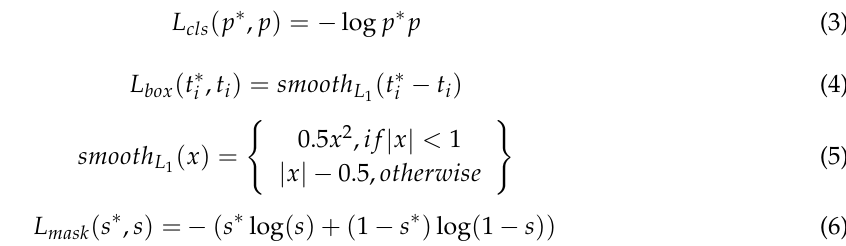
Figure 5. Pipeline of Receptive Field Block (RFB) modules stacked network.